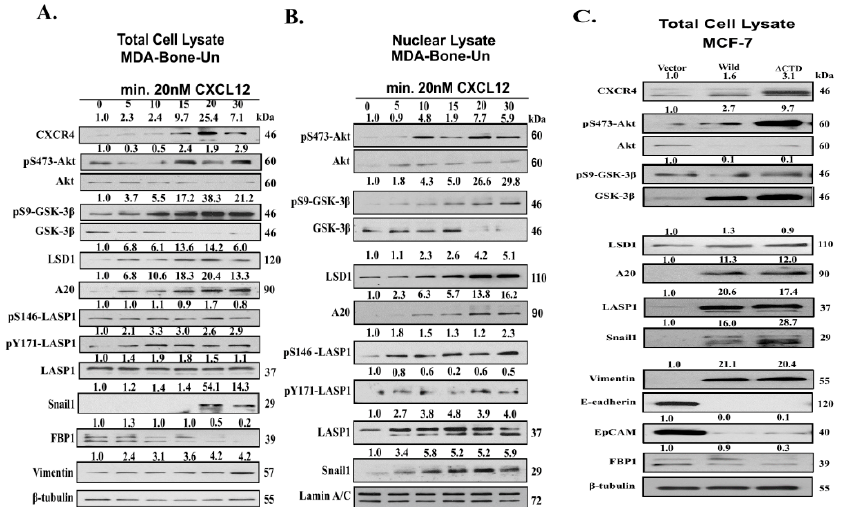
Figure 2. Nuclear Snail1 is stabilized upon activation of CXCR4 by CXCL12. ( A ) MDA-Bone-Un cells were stimulated with 20 nM CXCL12 for 0–30 min. The harvested ( A ) total protein lysates or ( B ) nuclear lysates were separated by 10% SDS-PAGE and subjected to Western blot analysis. The protein levels of Snail1 and proteins implicated in the Snail1 stabilization, such as AKT, GSK-3 β , A20, LASP1, and LSD1 were analyzed and expressed as mean ± SD for 3 independent experiments ( n = 3). Moreover, β -tubulin and Lamin A/C levels were employed as loading controls for total cell and nuclear lysate respectively. ( C ) MCF-7/Vector, MCF-7/CXCR4-WT, and MCF-7/ CXCR4- Δ CTD total protein lysates were subject to Western blotting. The protein levels of AKT, GSK-3 β , LSD1, A20, LASP1, Snail1, and other EMT makers were measured and normalized to the levels of the β -tubulin as the loading control. The values were expressed as mean ± SD for 3 independent experiments ( n = 3).